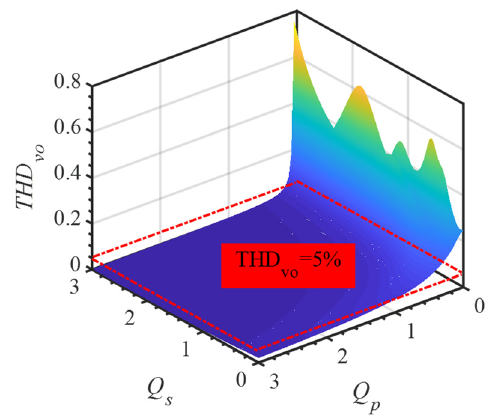
Figure 3. Relationship among THD vo , Q s and Q p .